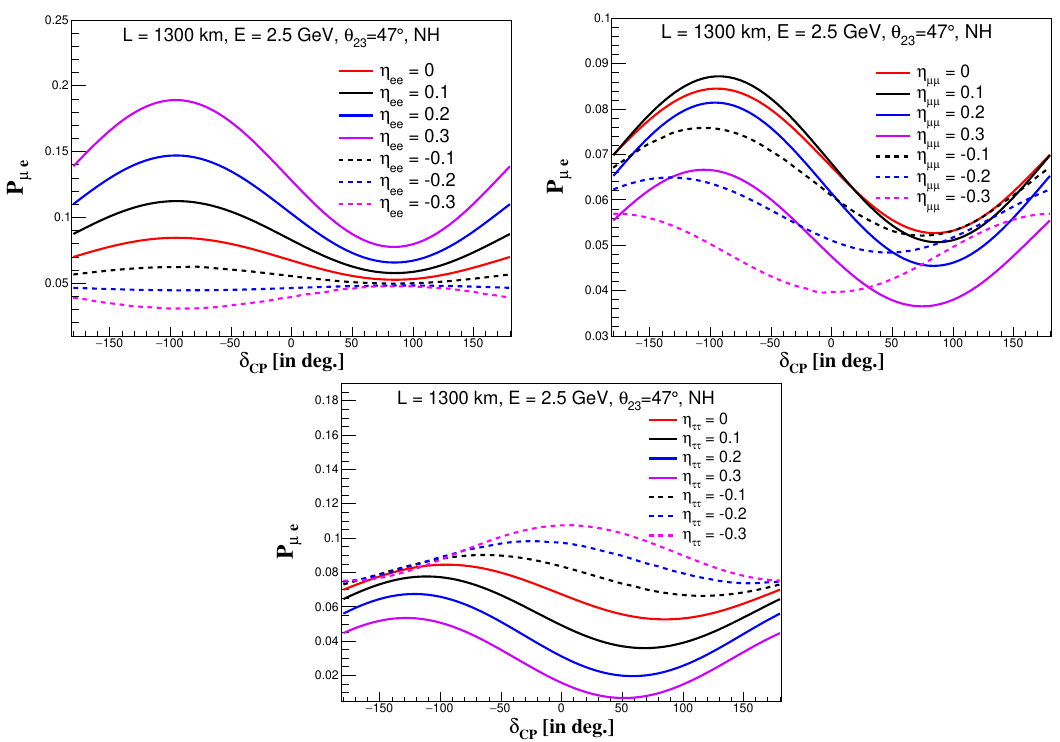
Figure 2 . The effects of η ee (top-left panel), η µµ (top-right panel), and η ττ (bottom panel) on P µe as a function of δ CP at θ 23 = 47 ◦ and E = 2 . 5 GeV. In every panel, the red-solid line is for η αβ = 0 (i.e, the SI case), and other solid (dashed) coloured lines are for positive (negative) non-zero values of η αβ